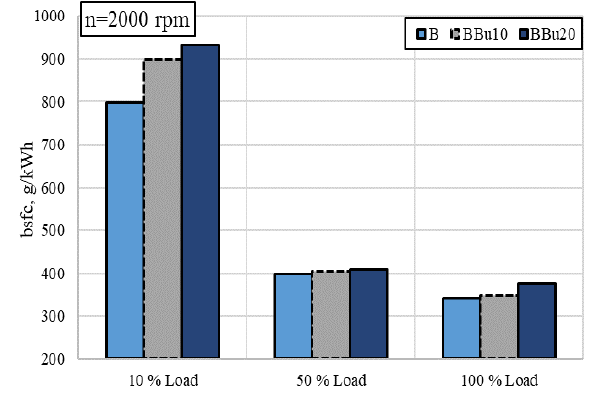
Fig. 2. The brake specific fuel consumption (bsfc) as a function of engine load when running at maximum torque speed of 2000